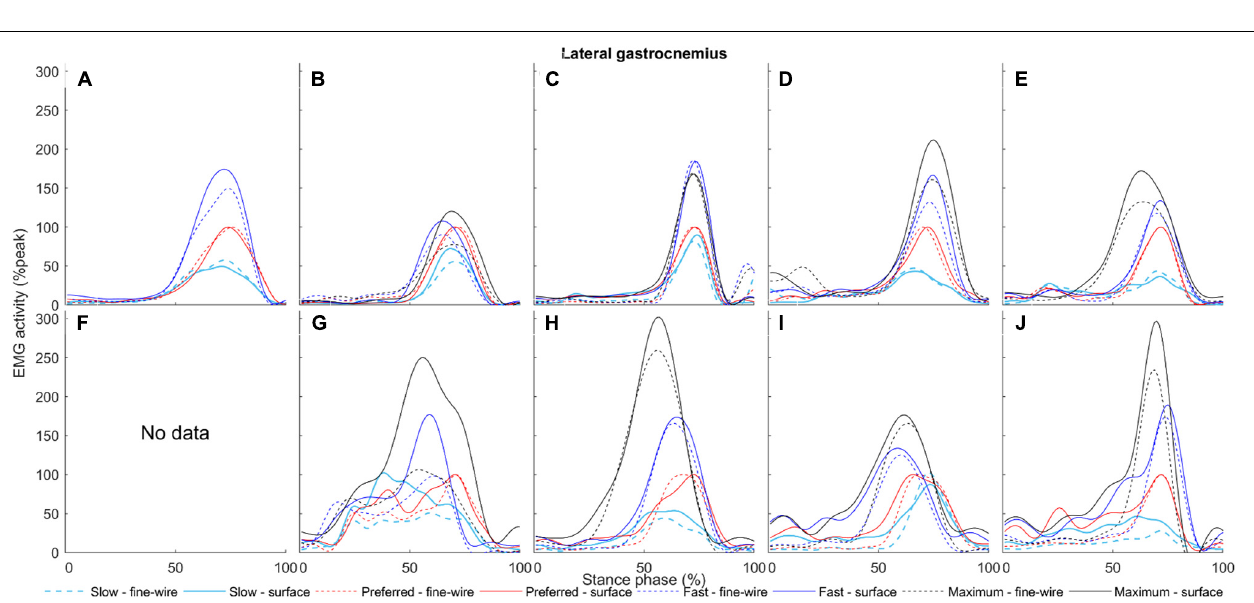
FIGURE 10 | Lateral gastrocnemius (solid) and intramuscular (dashed) electromyography (EMG) activity at slow, preferred, fast, and maximum walking speeds (1.01 ± 0.13, 1.43 ± 0.19, 1.84 ± 0.23, and 2.20 ± 0.38 m s − 1 , respectively) in the stance phase for each individual ( A–J , respectively). The amplitudes of smoothed and time-normalised EMG curves were normalised to peak activity in preferred speed walking (%peak). Each curve represents the average of all steps (number of steps included in the analysis were 14 ± 3, 12 ± 3, 11 ± 2, and 9 ± 1, median ± interquartile range, at slow, preferred, fast, and maximum walking speeds, respectively) at a given walking